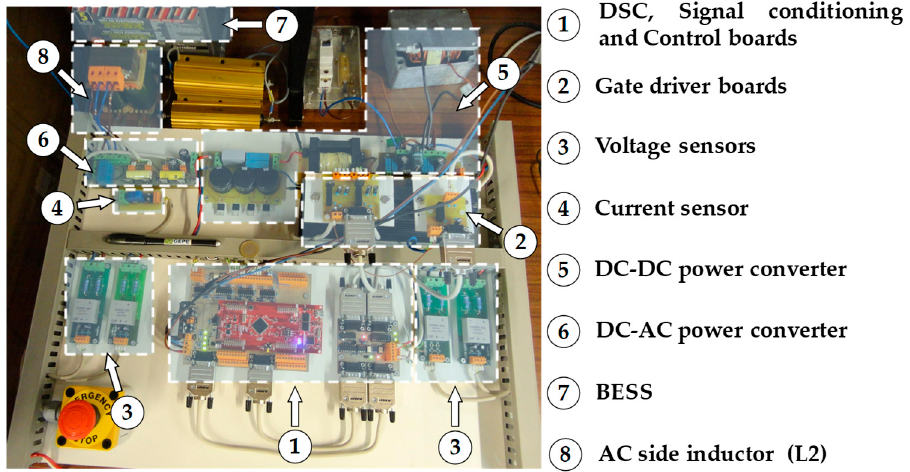
Figure 12. Top view of the developed multifunctional isolated microinverter prototype.